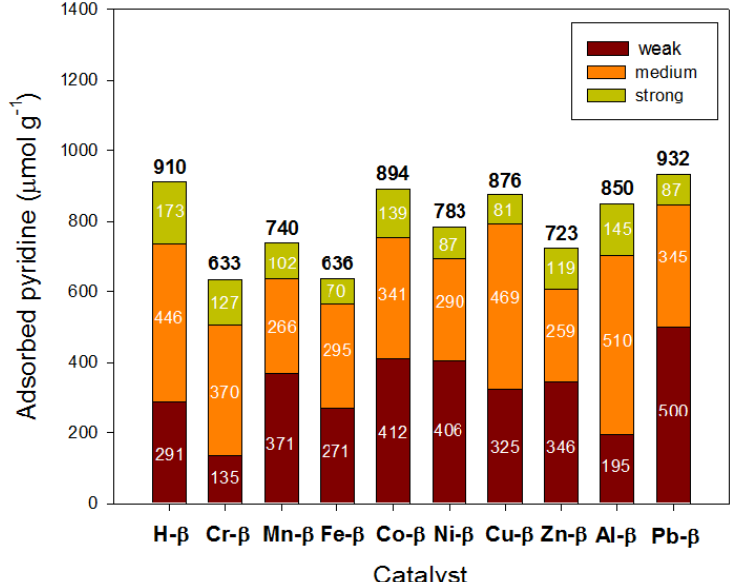
Figure 3. Surface acidity of metal exchanged β zeolites determined by thermal programmed desorption of